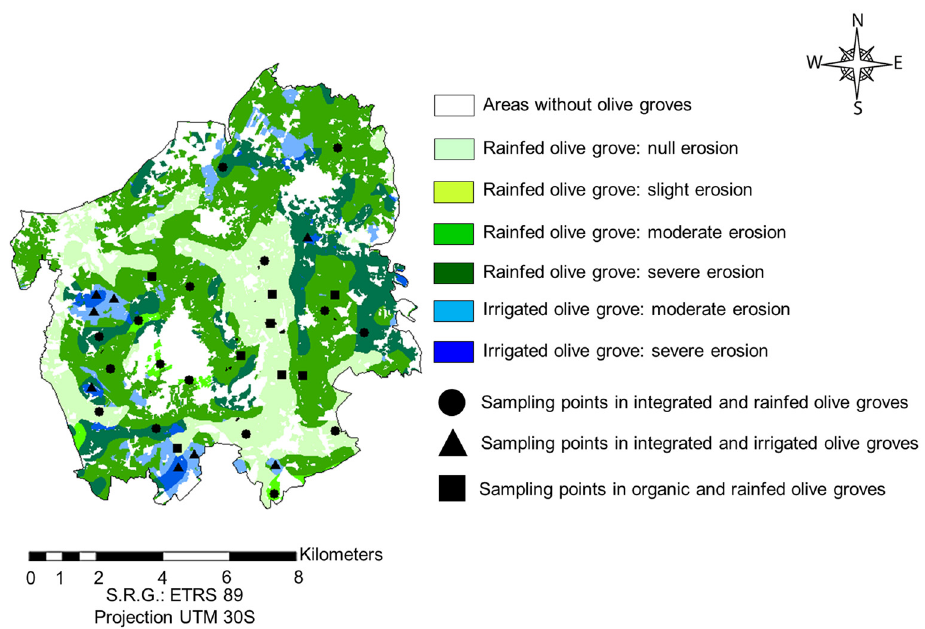
Figure 3. Sampling design carried out in previous studies in the PDO Estepa. The water regimes of the study area are shown (i.e., rainfed and irrigated), together with the erosive states (i.e., null, slight, moderate, and severe). The olive grove of the whole study area is managed in an integrated way, with the exception of isolated plots managed in an organic way.